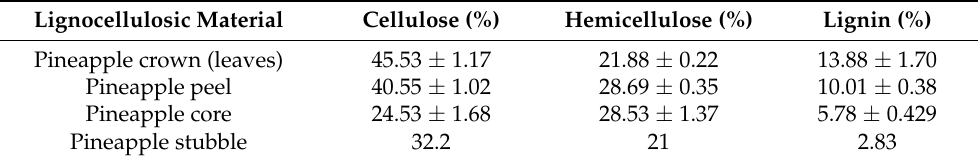
Table 3. Lignocellulosic material composition